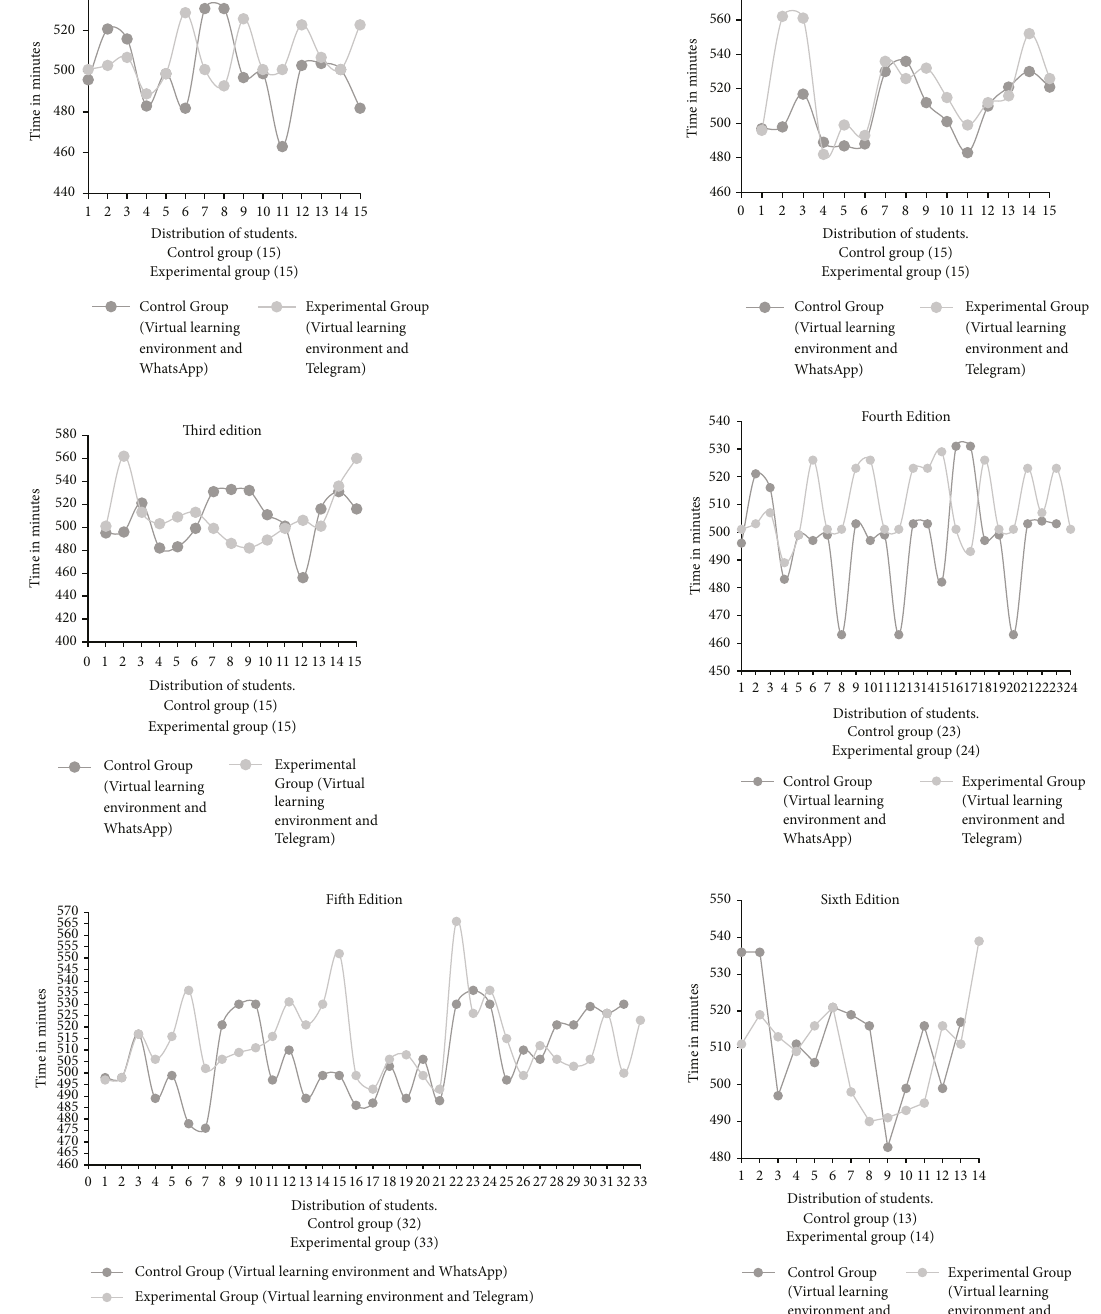
Figure 3: Scatter plot of the time spent according to the editions of the